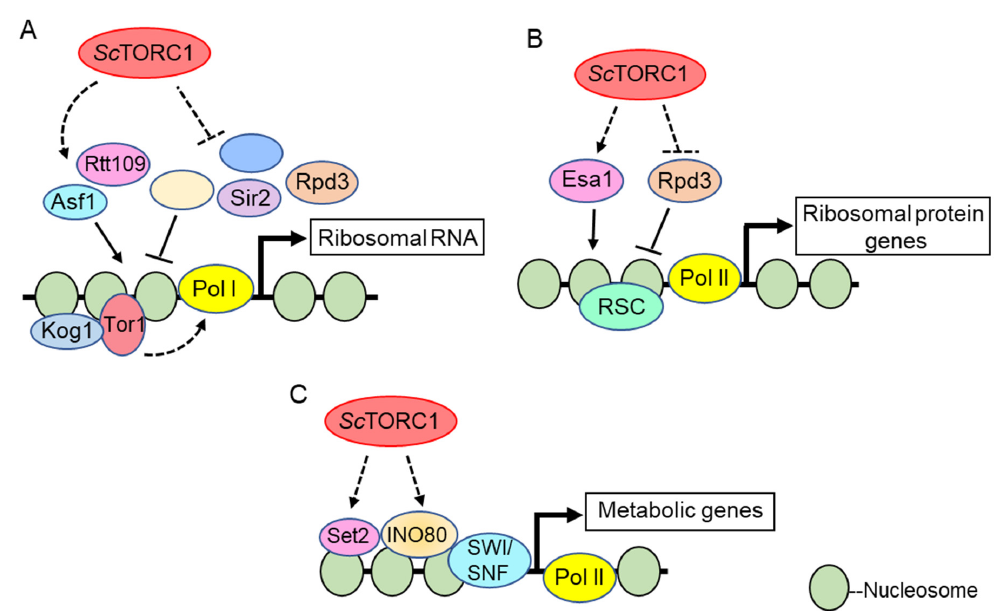
Figure 1. Role of the Sc TORC1 complex in epigenetic and transcriptional regulation. Known Sc TORC1 downstream epigenetic and transcriptional effectors at the rDNA ( A ), RP genes ( B ), and metabolic genes ( C ). Dashed arrows indicate regulation that is either indirect, or not yet known to be direct. Solid lines indicate direct regulation. Those pathways whose mechanisms have been described in detail are illustrated. Details are described in the text.